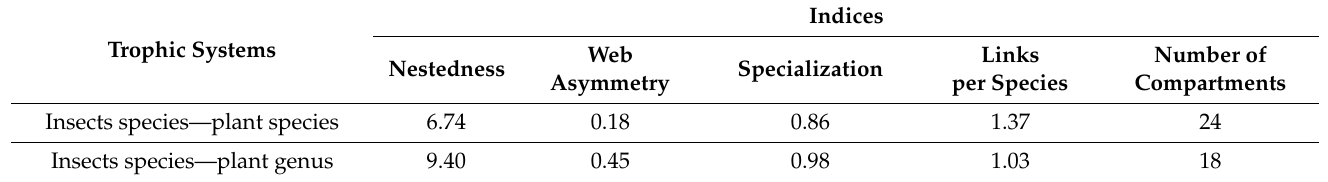
Table 3. Statistic indices reflecting different characteristics of the trophic network organization and specialization in the studied complex of leaf-mining insects on woody plants in the Volˇcji Potok Arboretum